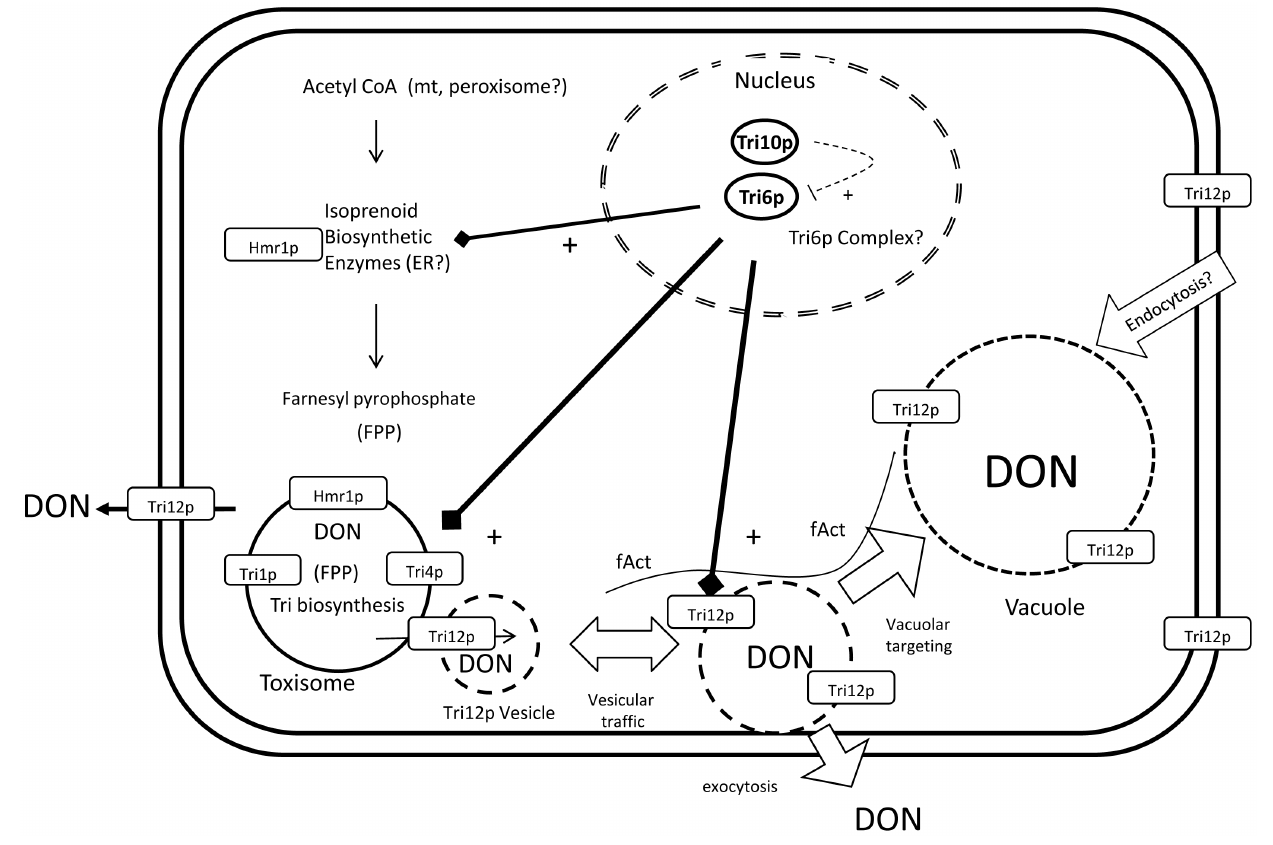
Figure 7. Model of trichothecene biosynthesis and export in F.graminearum . Within the nucleus, transcription factors Tri6p and Tri10p positively regulate transcription of genes involved in trichothecene (DON) biosynthesis and tolerance [22]. The genes for enzymes in the isoprenoid biosynthesis pathway, including HMG CoA reductase ( Hmr1 ), are constitutively expressed but are up-regulated during DON synthesis. DON biosynthesis induction leads to a shift in Hmr1p targeting from the ER to the toxisome. The vesicular toxisome is the site of trichothecene biosynthetic enzymes Tri1p and Tri4p, proteins that also are up-regulated under the control of Tri10p and Tri6p during DON biosynthesis. Also regulated by these transcription factors is the DHA14 protein Tri12p that confers a level of tolerance to DON [23]. Motility of Tri12p::GFP labeled vesicles appears to be dependent upon F-actin and results in fusion with the vacuole and the plasma membrane [23]. DON synthesis therefore may be sequestered within the toxisome and export of toxic products may be facilitated by trafficking of Tri12p::GFP labeled